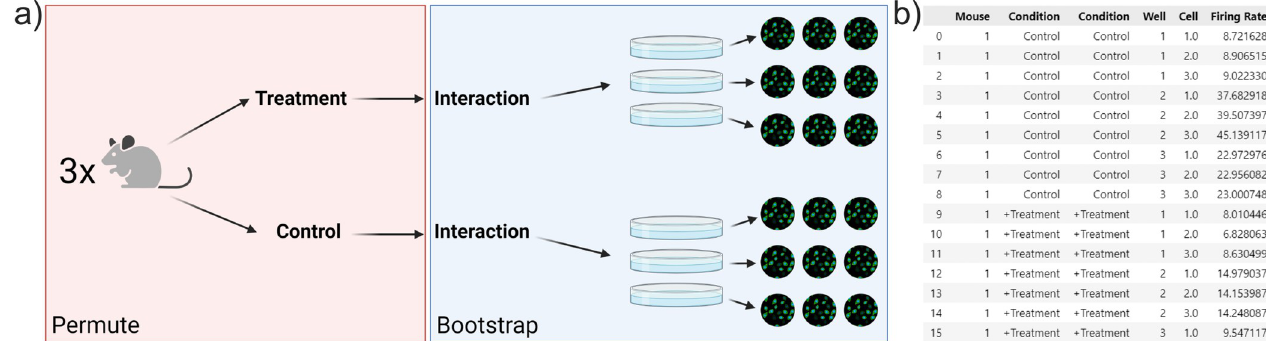
Fig 7. Incorporating heterogeneous treatment effects. (A) Adding a mouse-treatment interaction term to the experiment design describes heterogeneity of treatment effects. (B) By duplicating the “Condition” column in the input data, Hierarch will account for this interaction. Panel (A) was created using